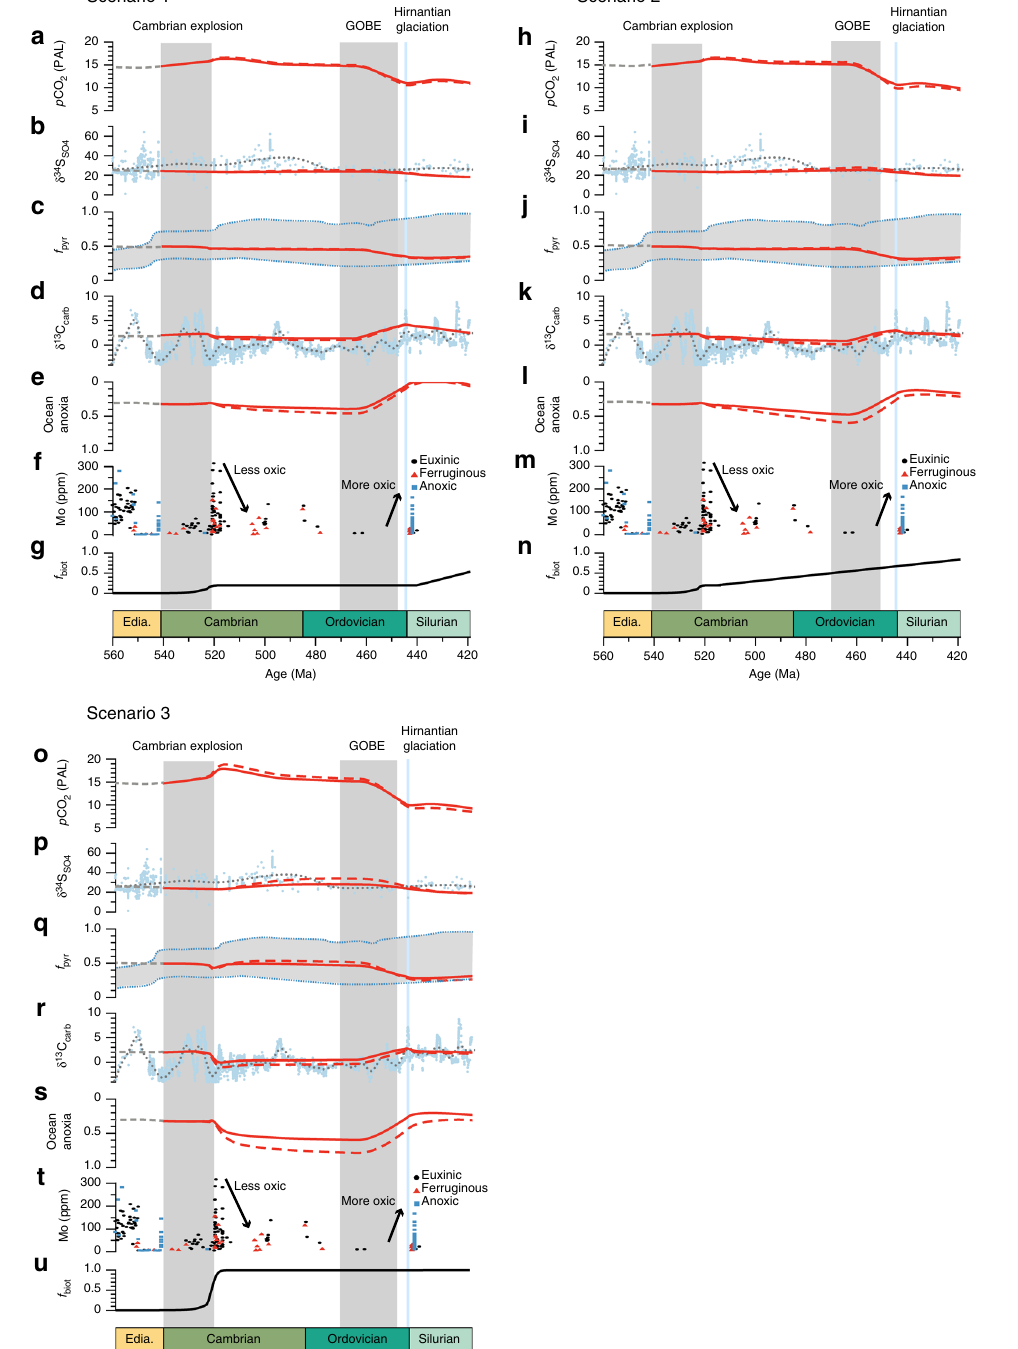
NATURE COMMUNICATIONS| (2018) 9:2554 |DOI: